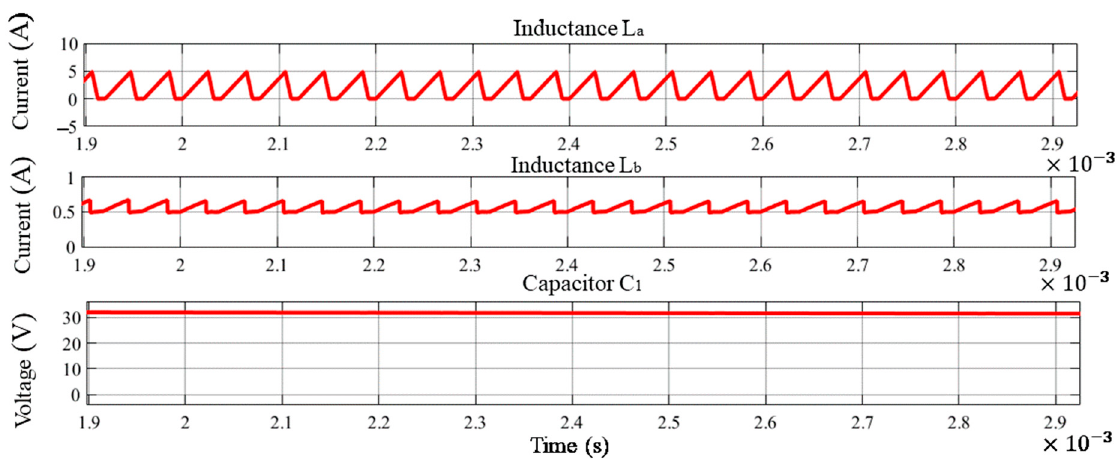
Figure 9. Simulation response of input inductor currents and capacitance voltage.